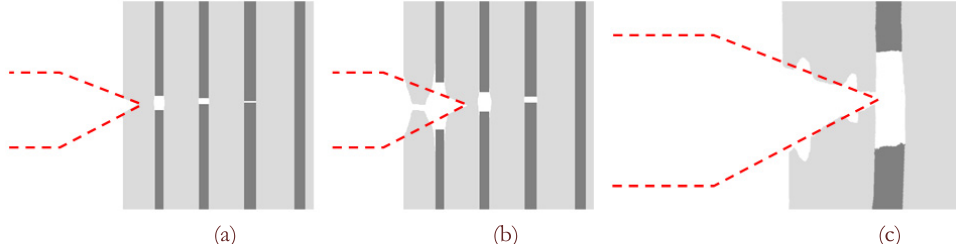
Figura 7: Schema di propagazione di una cricca di fatica in una colonia perlitica (a,b); formazione di striature alla sommità di una lamella di ferrite rotta (c). Figure 7: Fatigue crack propagation model in a pearlitic colony (a,b); striation formation at the top of a broken ferrite lamella (c). In Fig.8 [6] è riportata la frattura per fatica in corrispondenza di valori di Δ K medi per una zona perlitica di cuore di una